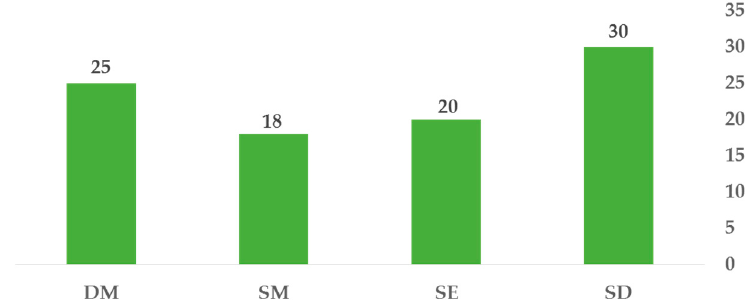
Figure 2. Antifungal activity of the extracts (sequential dichloromethane (SD) sequential ethyl acetate (SE), sequential methanolic (SM), direct methanolic (DM)) against Trichophyton mentagrophytes as the inhibition zone in agar diffusion (mm).